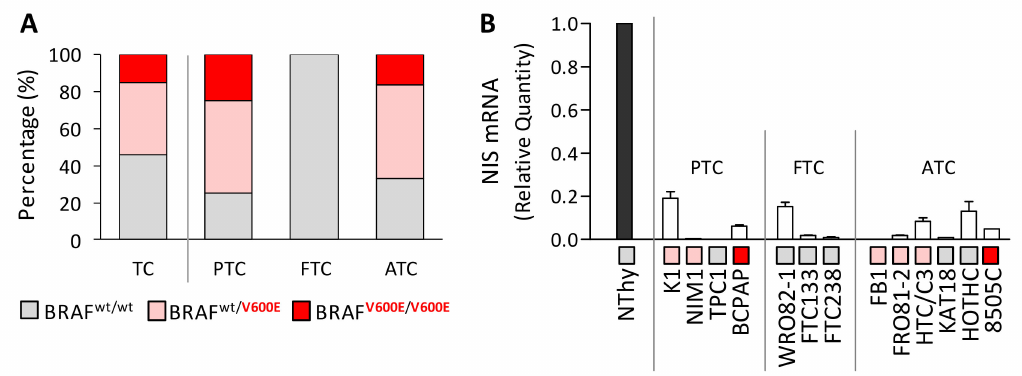
Figure 1. BRAF V600E mutation and NIS expression in thyroid cancer cell lines. ( A ) BRAF V600E distribution in TC cell lines and in the same cell panel stratified according to tumor histotype. Complete BRAF mutation data available in Suppl. Table S1. ( B ) NIS expression by quantitative RT-PCR; data are reported as relative quantity normalized to HPRT gene used as endogenous control for RNA input normalization and are shown relative to the control cell line Nthy; mean ± SEM of three technical replicates. For each cell line, the BRAF mutational status is indicated with a color code legend as in ( A ). Abbreviations: TC, Thyroid Cancer; PTC, Papillary Thyroid Cancer; FTC, Follicular Thyroid Cancer; ATC, Anaplastic Thyroid Cancer; wt,